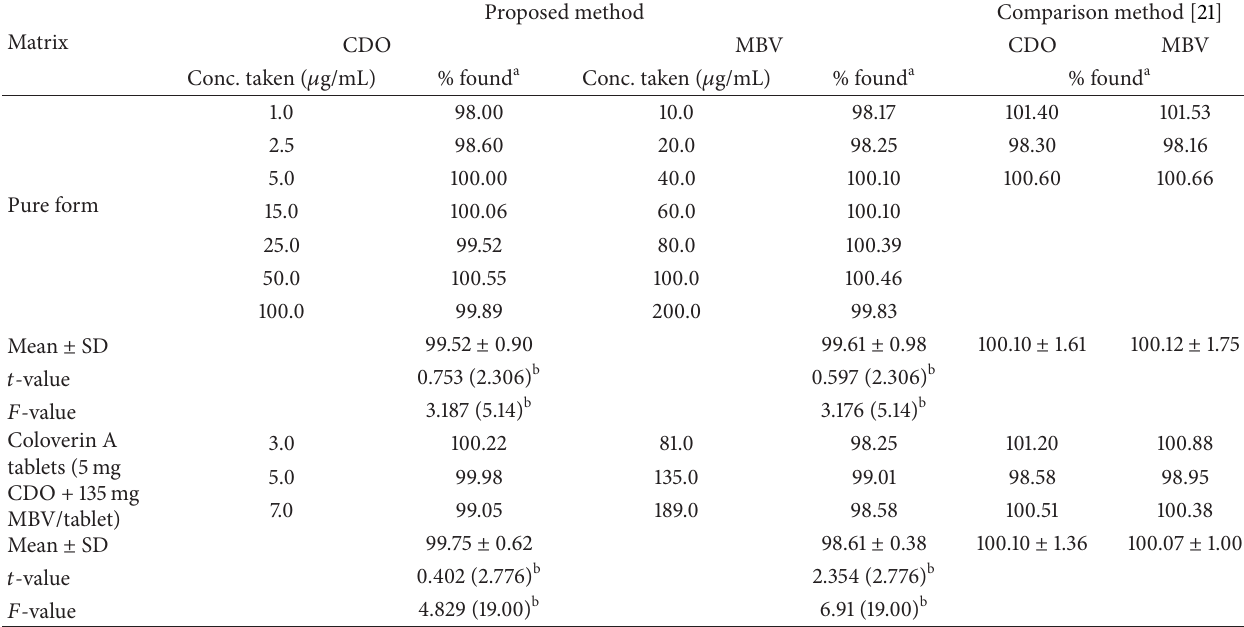
Table 2: Application of the proposed and comparison methods for the determination of CDO and MBV in pure form and coformulated tablets.